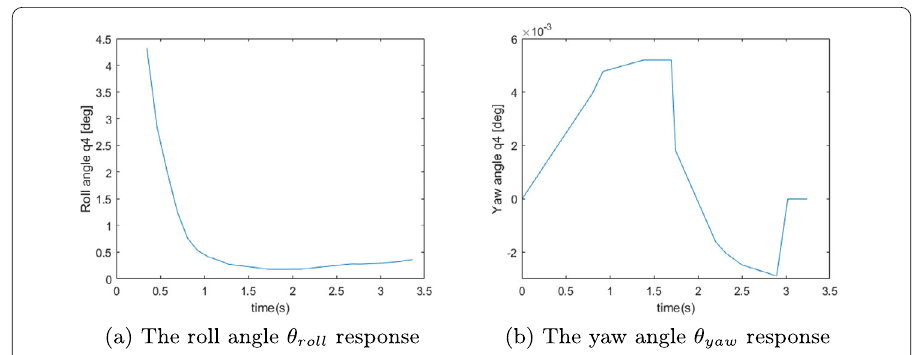
Figure 30 Backstepping control response results for the delay model with parameters c 1 = 10, c 2 = 5, c 3 = 5